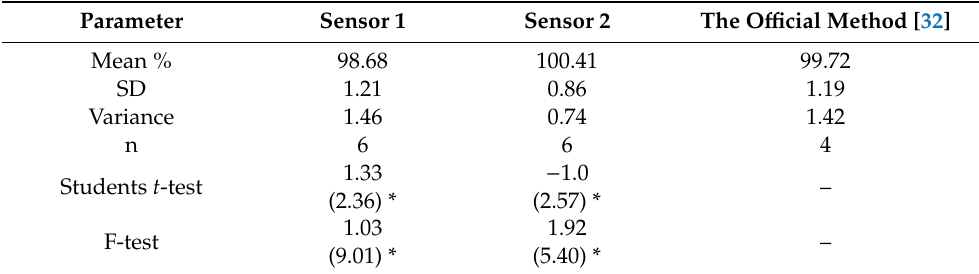
Table 7. Statistical comparison between the determination of carbachol and the o ffi cial